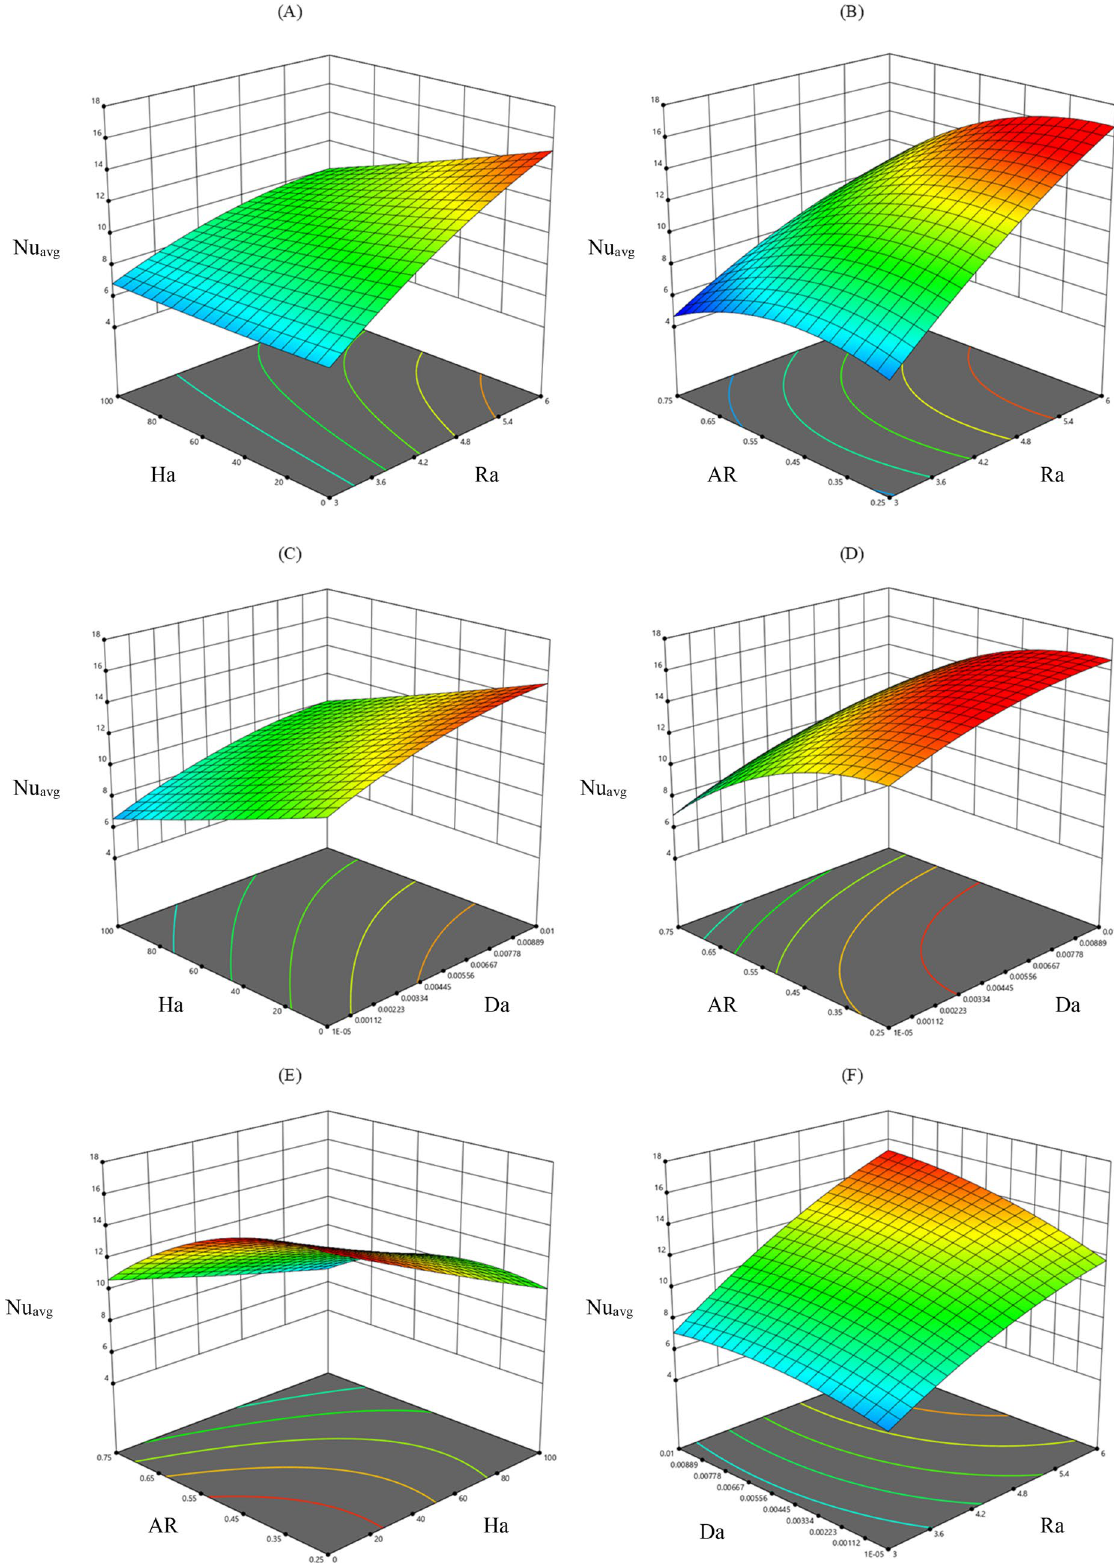
Figure 7. The variation of average Nu in various